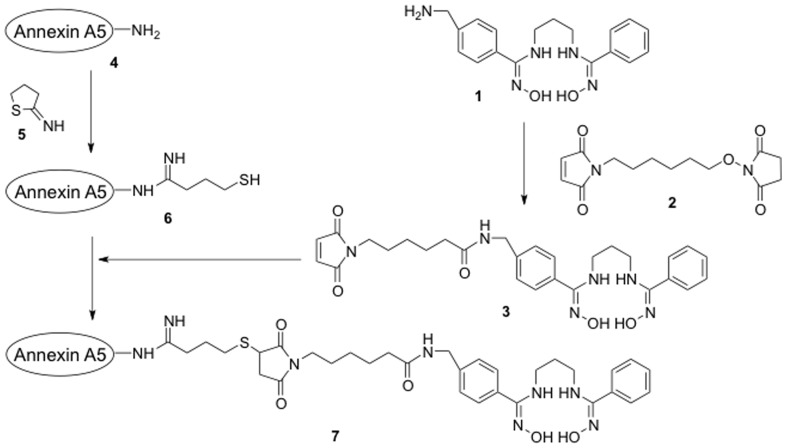
Preparation of C3(BHam)2-annexin A5.